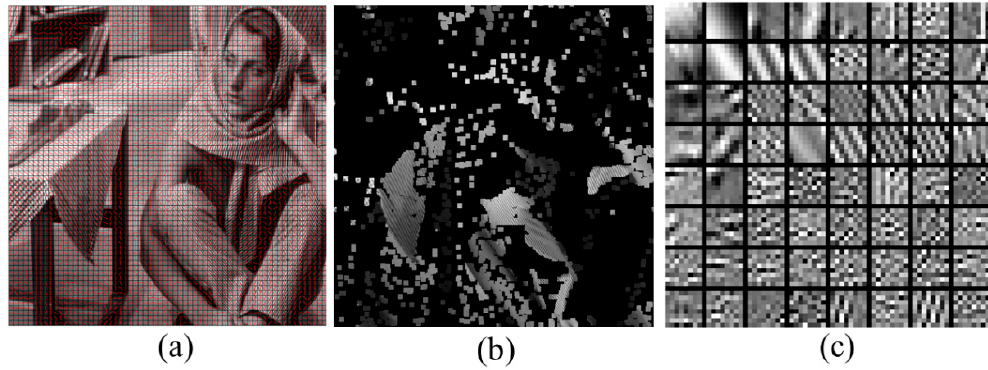
Figure 2. Adaptive representations learnt with FDLCP. ( a ) Geometric directions estimated from the Barbara image, ( b ) one class of image patches that share the same geometric direction, ( c ) one dictionary learnt from the class of patches in ( b ). Note: red lines in ( a ) indicate geometric directions of image patches.